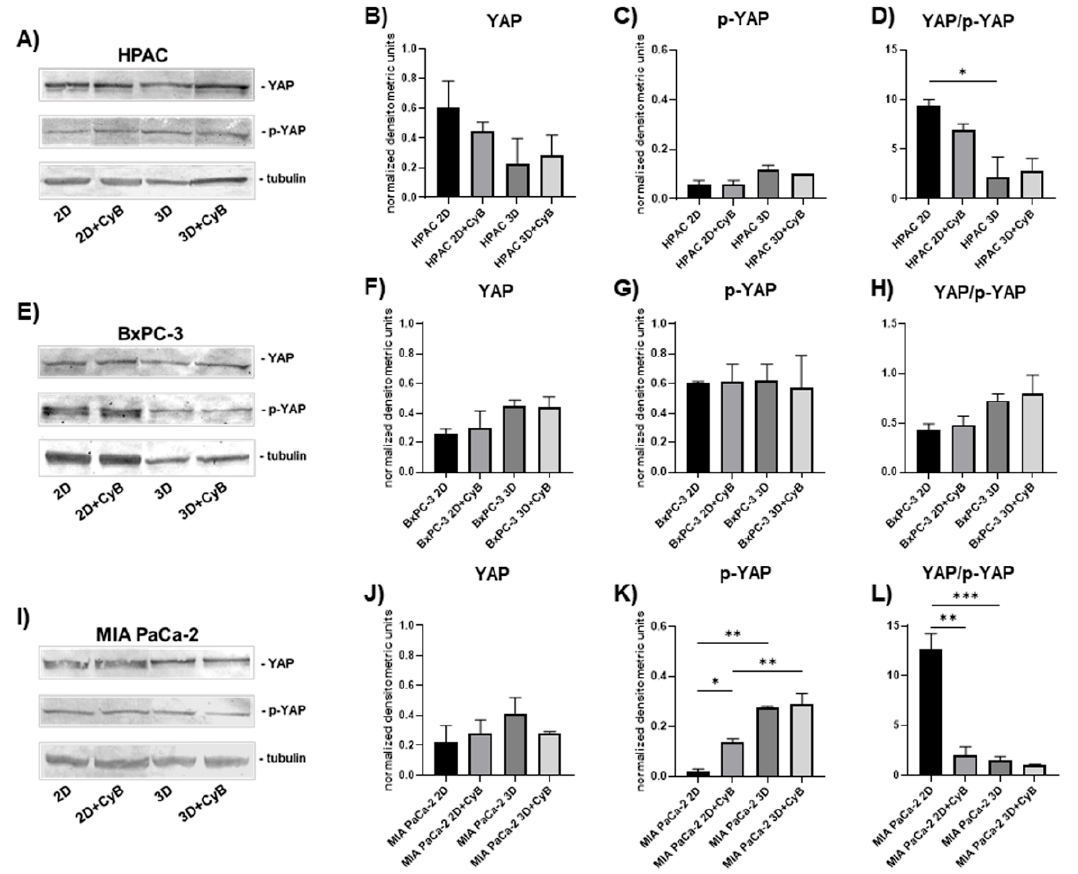
Figure 9. Representative Western blot showing YAP and p-YAP expression in whole cell lysates of HPAC ( A ), BxPC-3 ( E ) and MIA PaCa-2 cells ( I ). Bar graphs showing YAP, p-YAP and the YAP/p-YAP ratio, respectively, in HPAC ( B – D ), BxPC-3 ( F – H ) and MIA PaCa-2 cells ( J – L ). Data are expressed as mean ± SD. * p < 0.05, ** p < 0.01, *** p < 0.001.